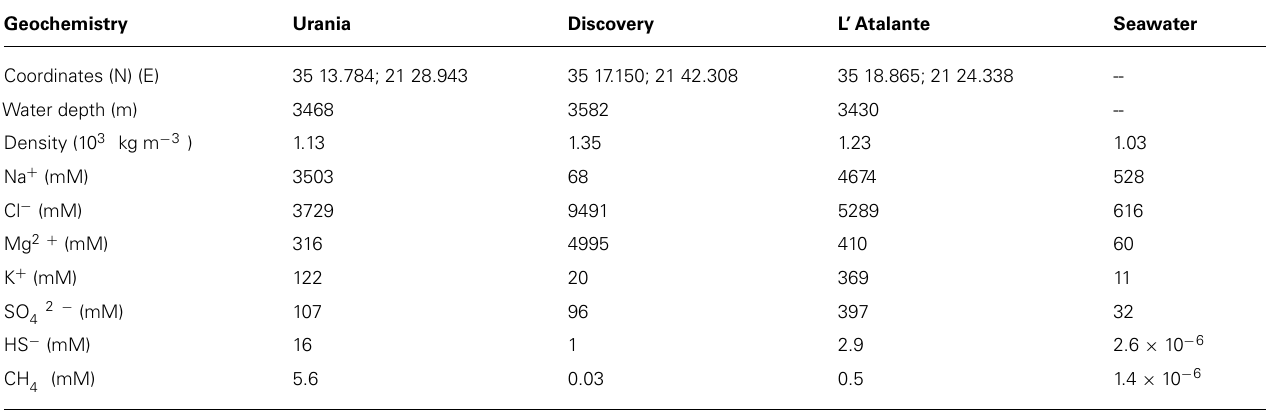
Table 1 | Geochemical data of DHAB brines and typical seawater (modified from van derWielen etal., 2005). Geochemistry Urania